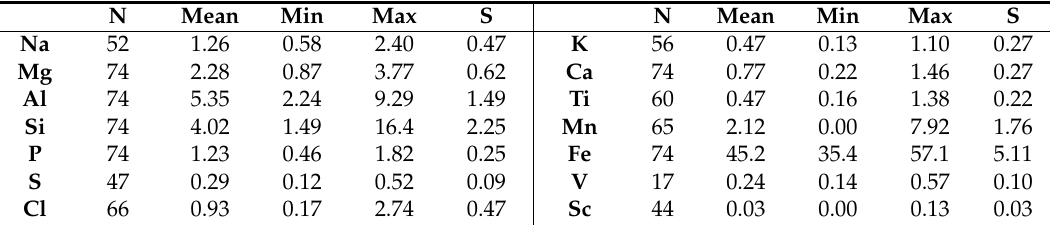
Figure 7. SEM photos with EDS element mapping of the iron mineral association. Table 5. Statistics for the chemical composition of the iron mineral association in wt %.